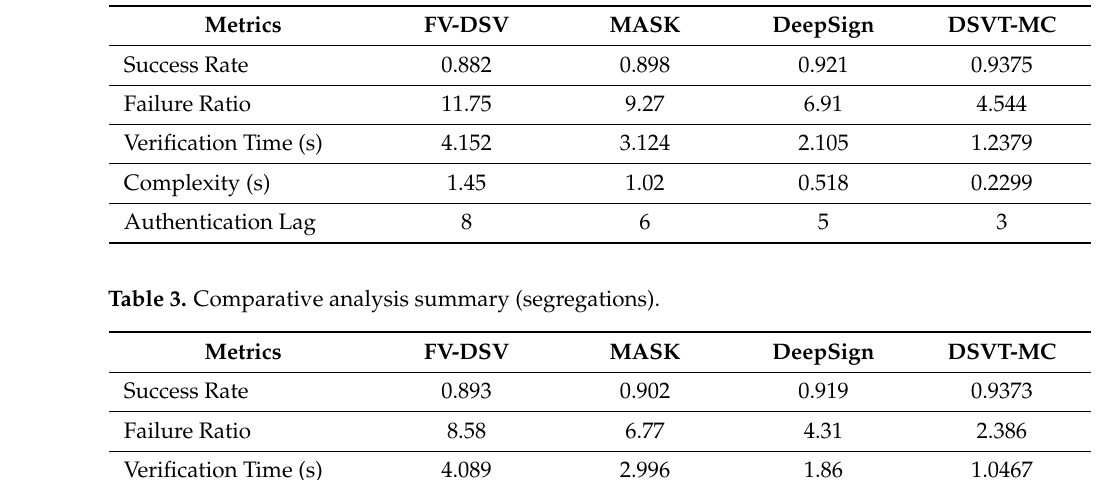
Figure 14. Authentication Lag for ( a ) different session ( b ) Segregation.